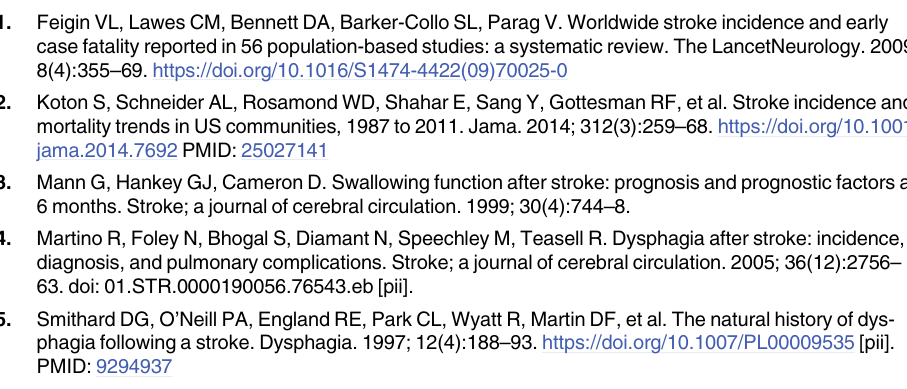
S1 Fig. Flow diagram indicating selection of the study population. (cid:3) Not mutually exclusive. (TIF) S1 Table. Multivariable analysis for race and sex determinants of non-beneficial PEG placement after stroke. Sensitivity analysis including imputed data for race; n = 42,235. S2 Table. Sensitivity analysis: Odds of PEG among stroke patients who died or were dis- charge to hospice within 14 days of admission (n =